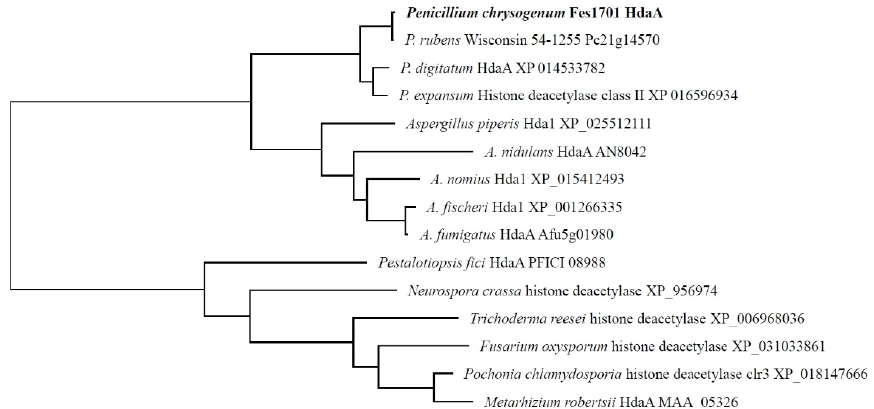
Figure 1. Phylogenetic tree analyses of HdaA in the strain Fes170 and its homologs from different species. Branch lengths are in proportion to distance.